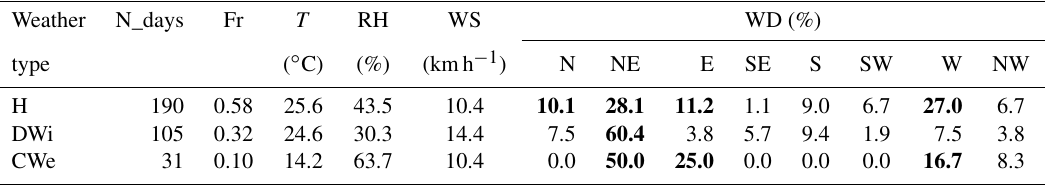
Table 1. Weather types obtained from the classification of the 326 fire weather days (N_days) according to the average values of tempera- ture ( T ), relative humidity (RH) and wind speed (WS). For each weather type (with frequency Fr), the percentage of each wind direction (WD) was calculated. In bold, wind direction frequencies above